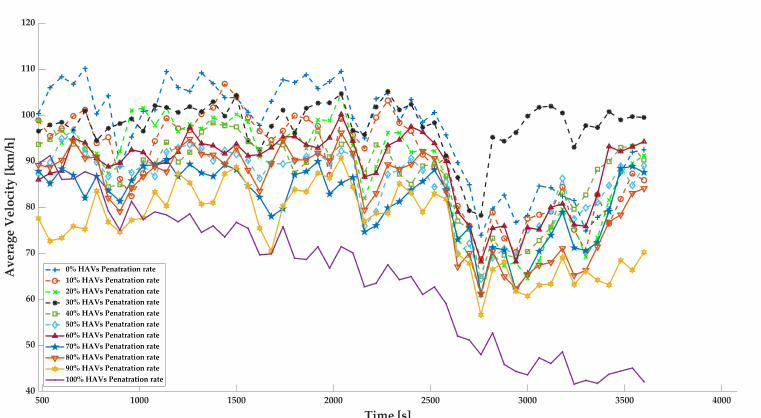
Figure 11. Average speed over the network for the various HAV penetration